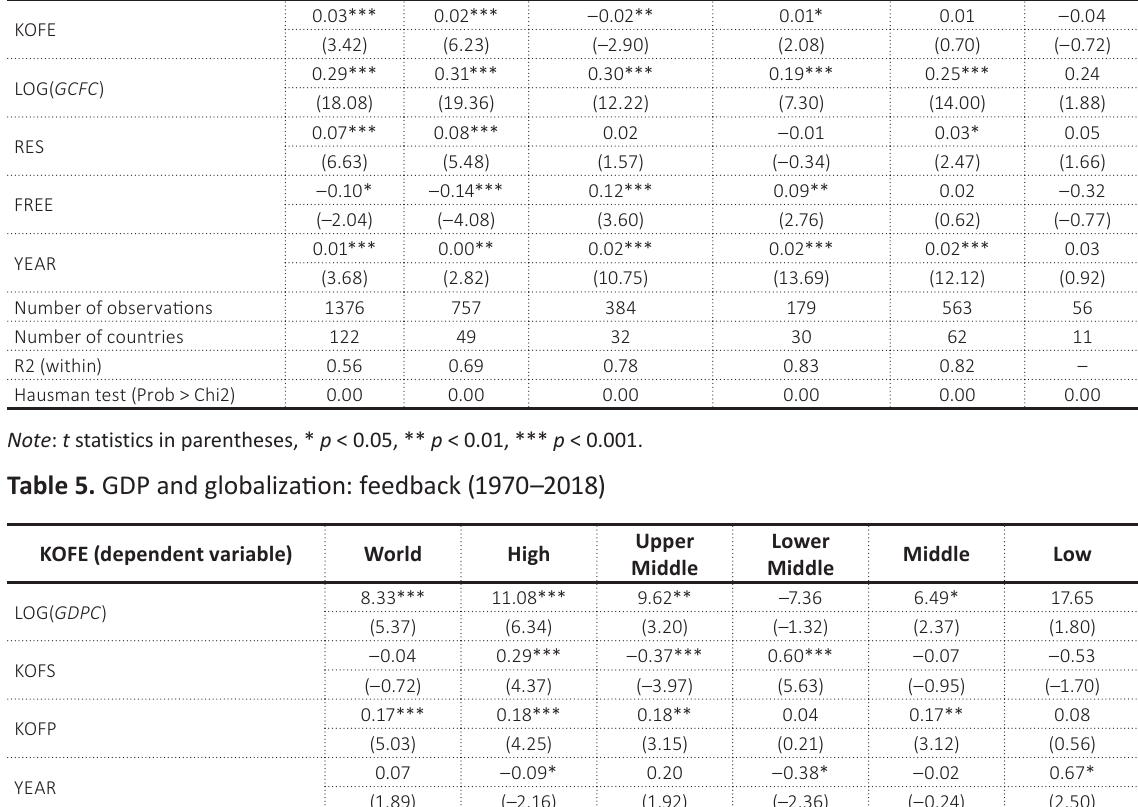
Table 4. GDP and globalization: a direct link (1970–2018) GDP (dependent variable)